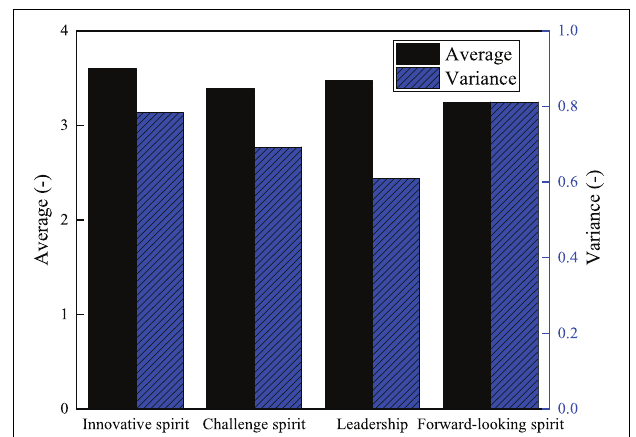
FIGURE 3 | Validity test results of the scale.